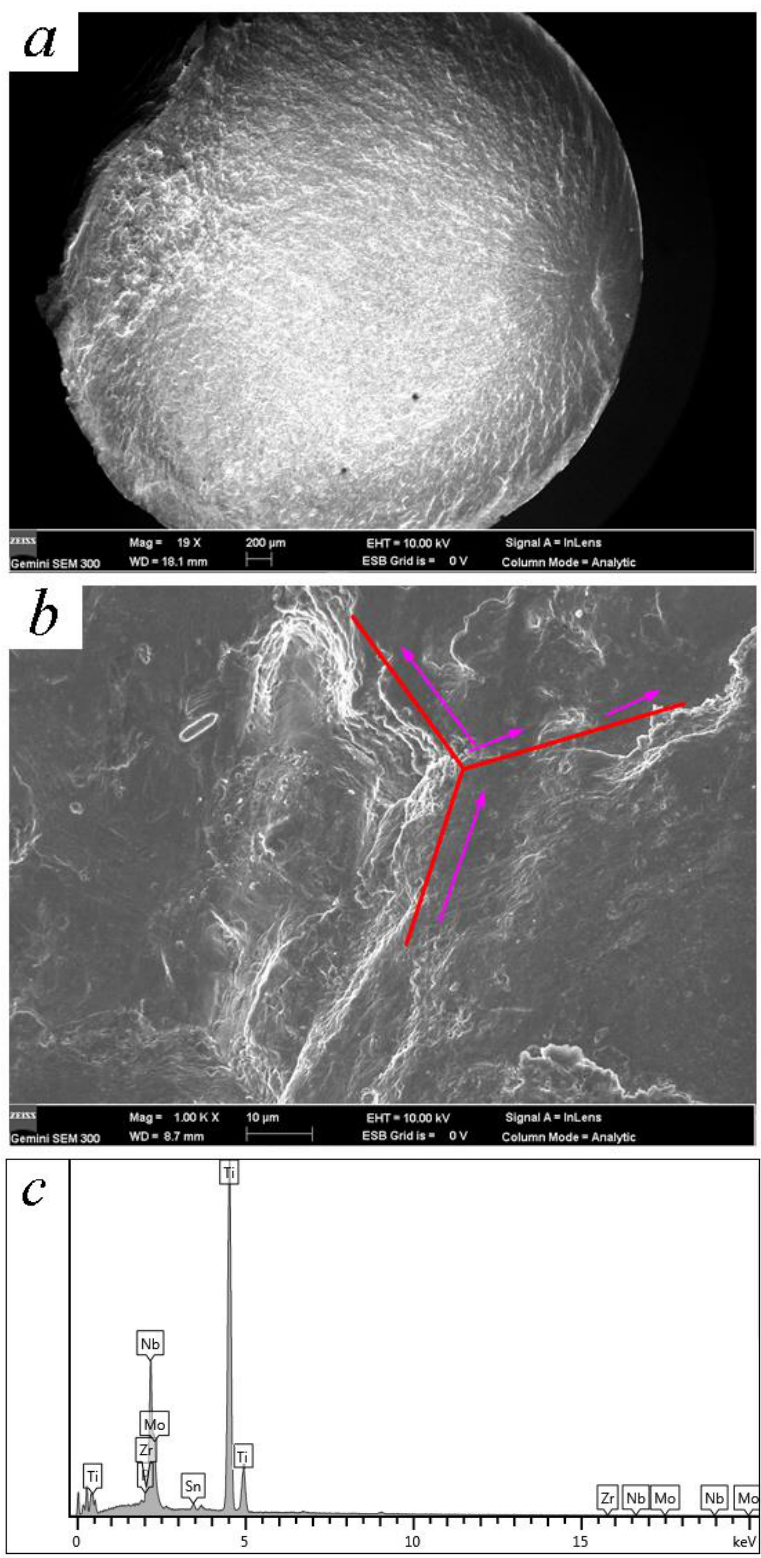
Figure 9. Fracture surface of TLM subjected to UI treatment (485 MPa, 5.83 × 10 6 cycles): ( a ) overall view of fracture surface; ( b ) illustration of the crack initiation; ( c ) EDX analysis of crack core.